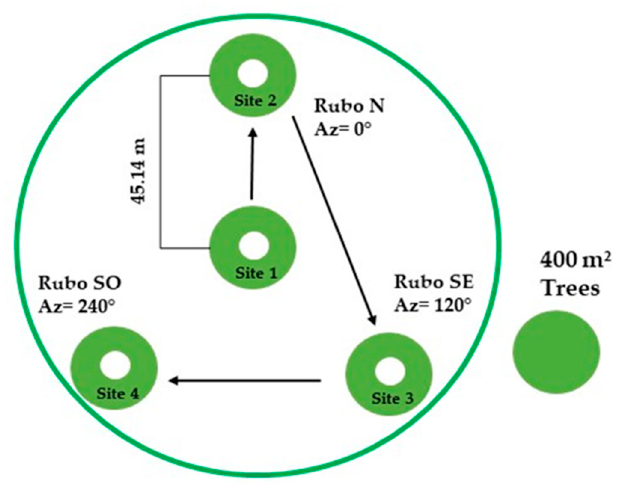
Figure 2. Conglomerates and sampling sites in the forest area. Data are from the State Forest and Soil Inventory of Tamaulipas 2009-2014.